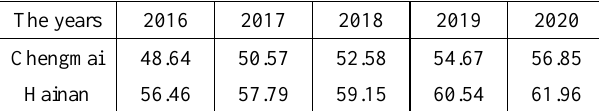
Table 2. Forecasted value of urbanization rate (2016-2020) Forecasted results showed that Chengmai urbanization level